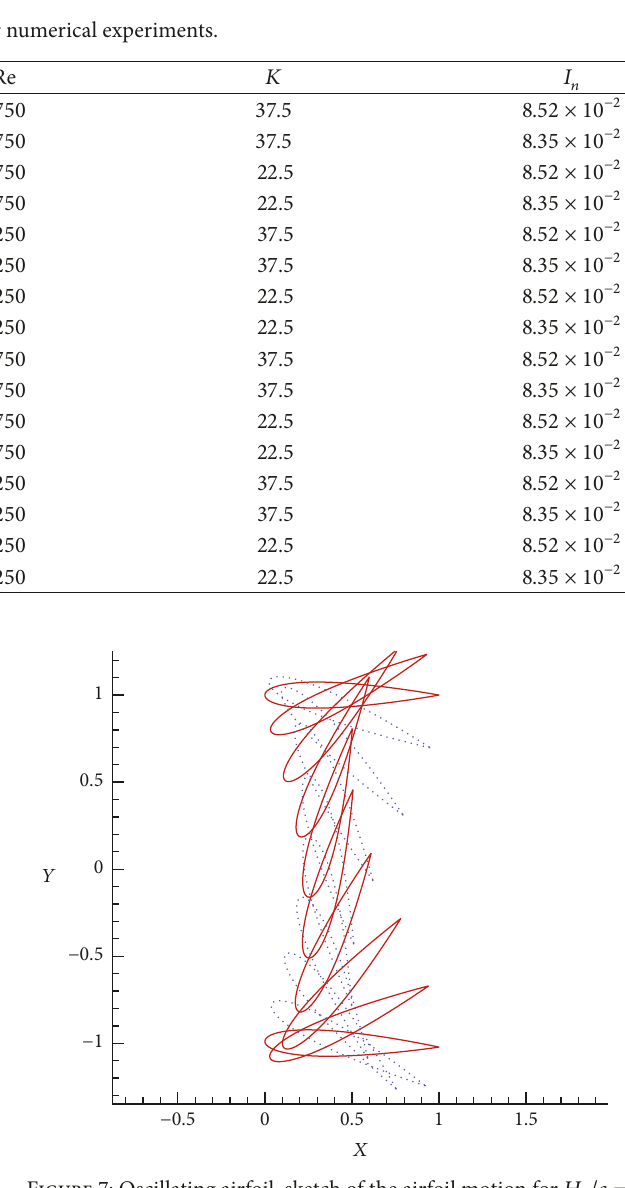
Figure 7: Oscillating airfoil, sketch of the airfoil motion for 𝐻 0 /𝑐 = 1 , 𝑓 = 0.14 , 𝑥 /𝑐 = 1/3 , and 𝜃 = 76.33 ∘ 𝑝 0